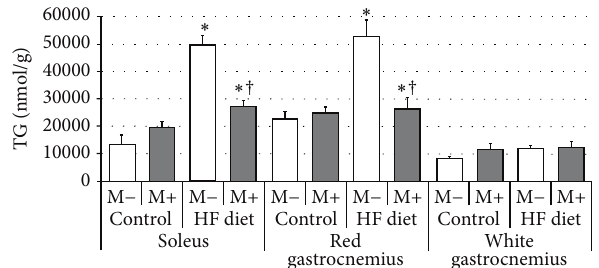
Figure 7: Effect of high-fat diet (HFD) feeding (5 weeks) and/or myriocin application (7 days) on triacylglycerols (TG) content in skeletal muscles ( 𝑛 (per group) = 8). M+: rats administered with myriocin. M − : untreated group. Results are expressed as means ± SD. ∗ 𝑝 < 0.05 compared with control group. † 𝑝 < 0.05 compared with HF diet